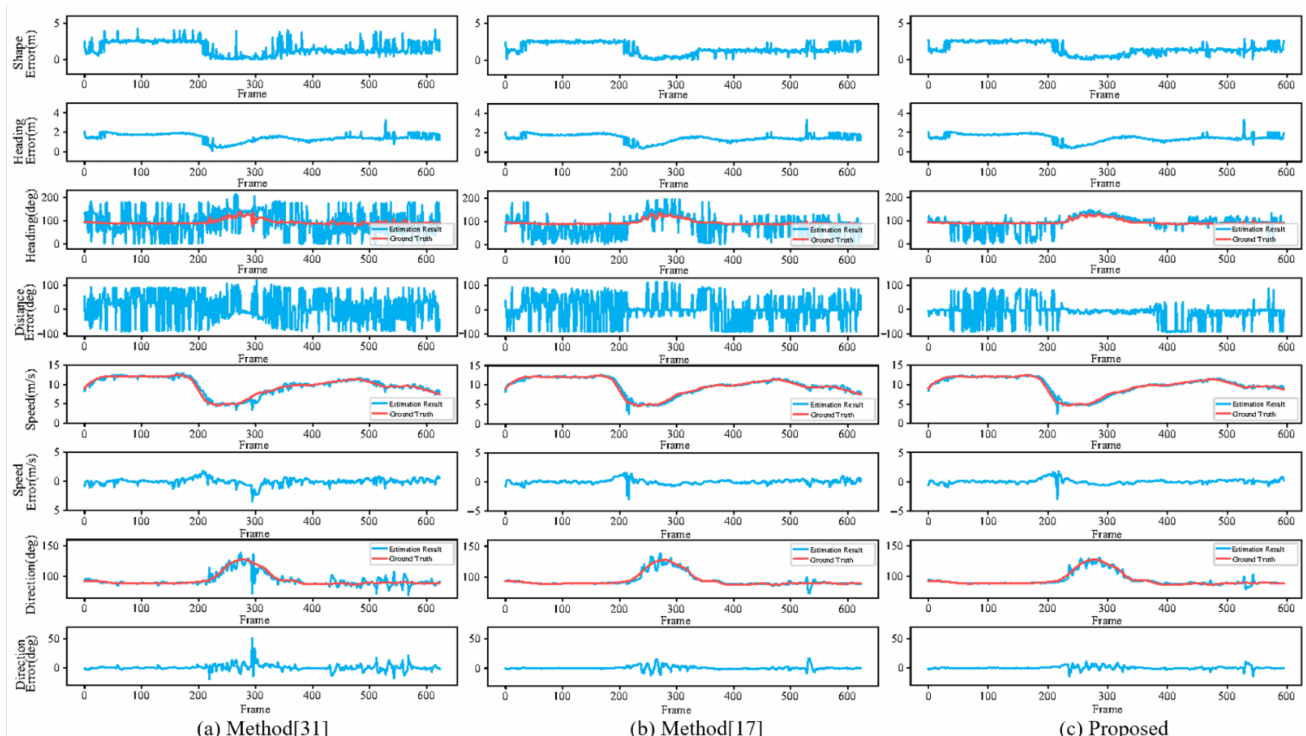
Figure 24. The experimental result’s curve of our experimental platform: ( a ) The Method[31]’s results. ( b ) The Method[17]’s results. ( c ) Our